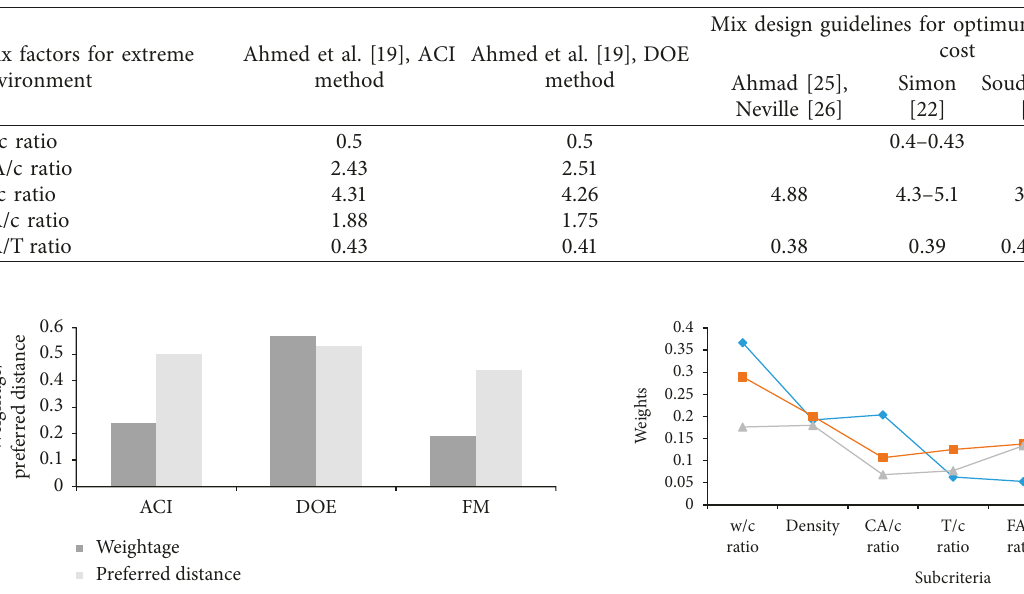
Table 4: Quantitative optimum values of mix factors from published literature.